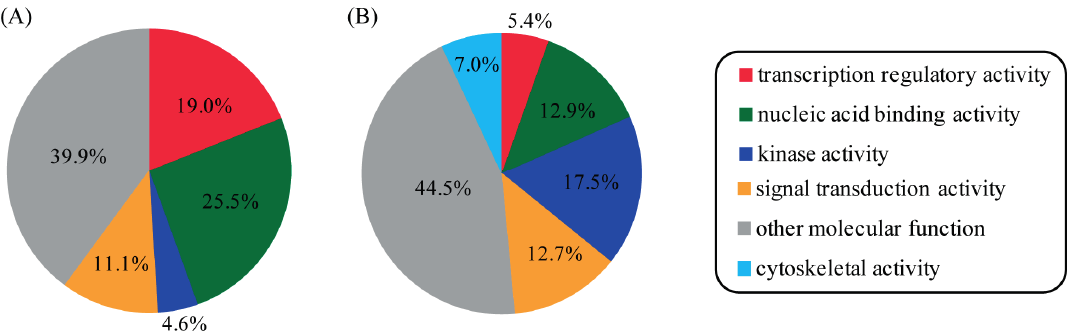
Figure 4. Functional clustering analysis of PR-interacting proteins. Proteins were mapped to GOslim terms under the molecular function category. This analysis was applied on the two different protein lists: ( A ) known PR-interacting proteins and ( B ) newly predicted PR-interacting